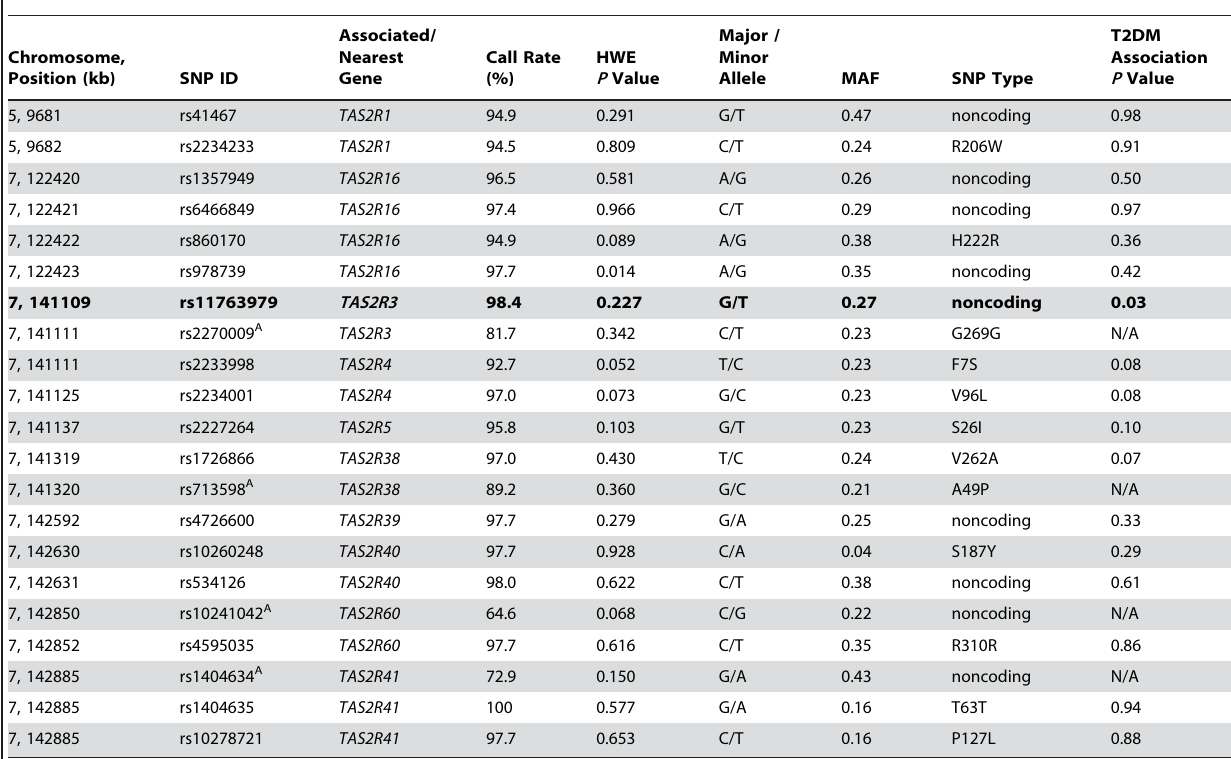
Table 2. Genotyping Statistics for chromosome 5 and 7 TAS2R SNPs tested in the AFDS.